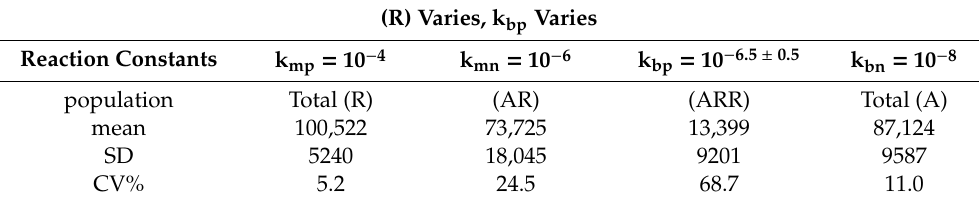
Table 7. Model calculation results for fluctuating ( R ) and fluctuating k bp .